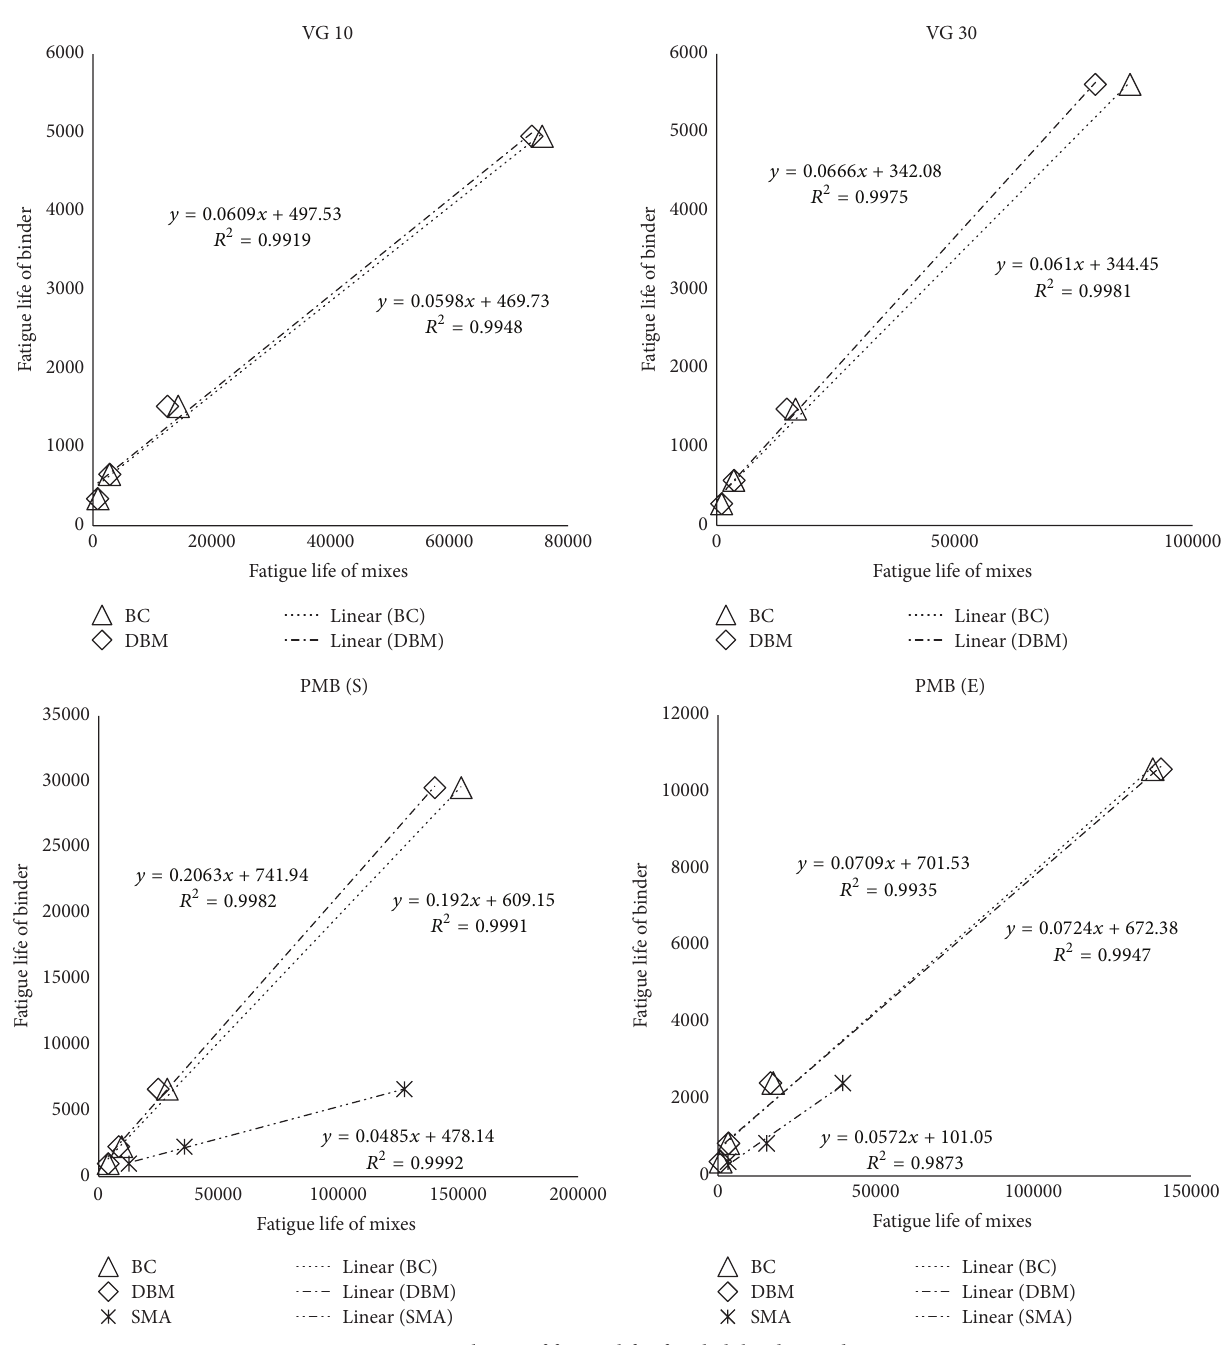
Figure 8: Correlation of fatigue life of asphalt binders and